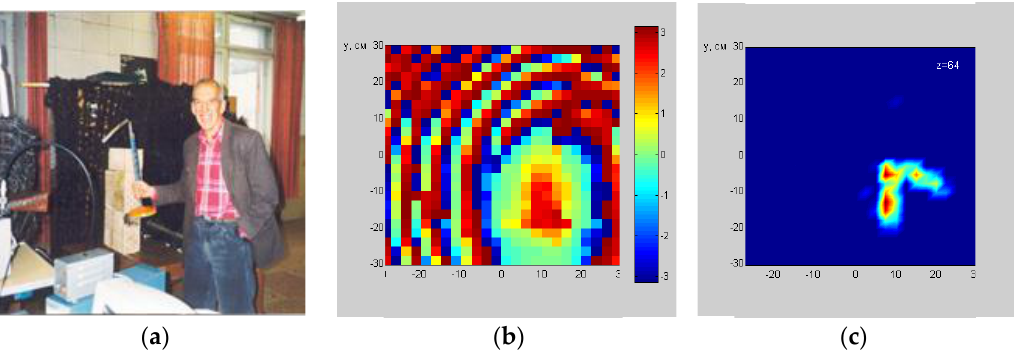
Figure 1. First laboratory tests: 10 GHz vertical E , harmonic illumination; simulated two-quadrature component, 25 × 25 element, antenna array. ( a ) Test object; ( b ) experimental phase hologram; ( c ) object reconstruction (Kirchhoff migration).